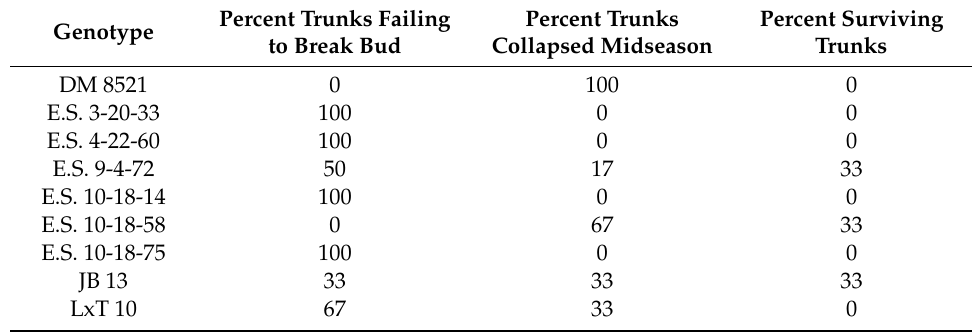
Table A1. Trunk survival of unreplicated cold-hardy grapevine genotypes (two-vine plot / genotype) at